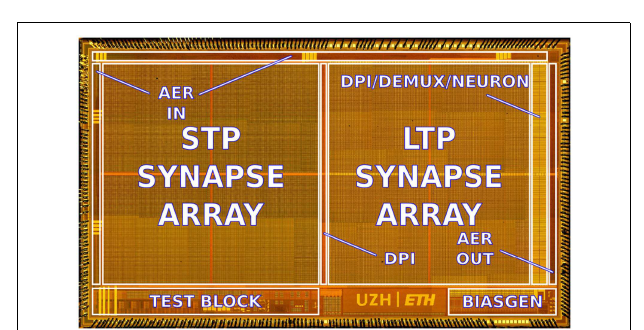
block is used to connect the rows from the synapse arrays to the neurons (see main text for details). Peripheral circuits include asynchronous digital AER logic blocks, an Analog-to-Digital converter, and a programmable on-chip bias-generator. (B) Block-diagram legend.